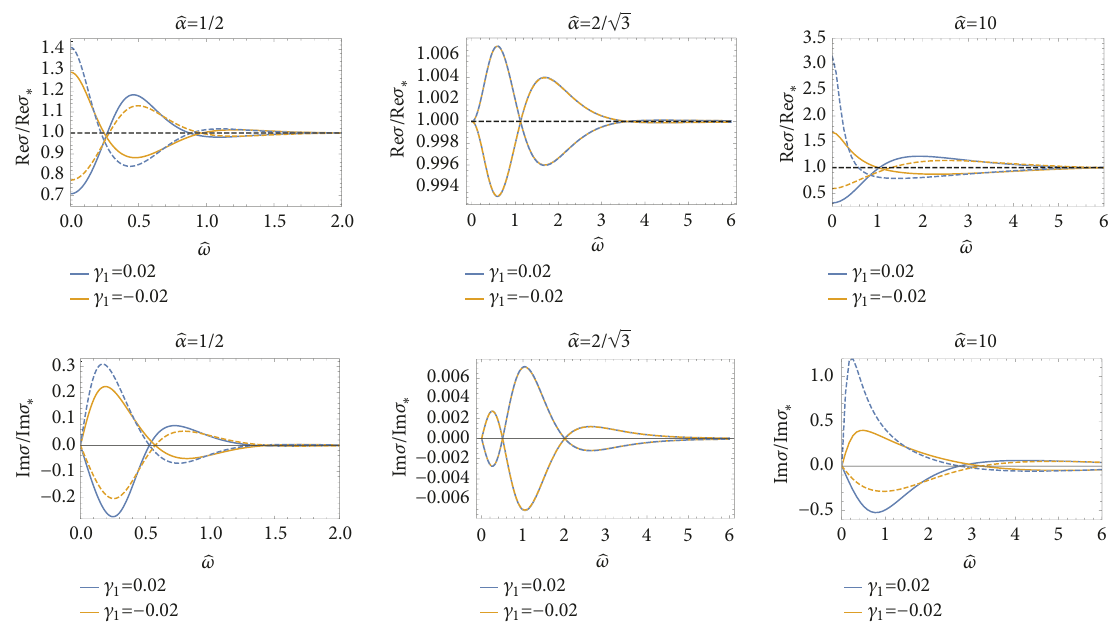
Figure 2: The real part (the plot above) and the imaginary part (the plot below) of the optical conductivity as the function of ̂𝜔 for |𝛾 1 | = 0.02 and various values of ̂𝛼 . The solid curves are the conductivity 𝜎 of the original EM theory (4) and the dashed curves display the conductivity 𝜎 ∗ of the EM dual theory (7).